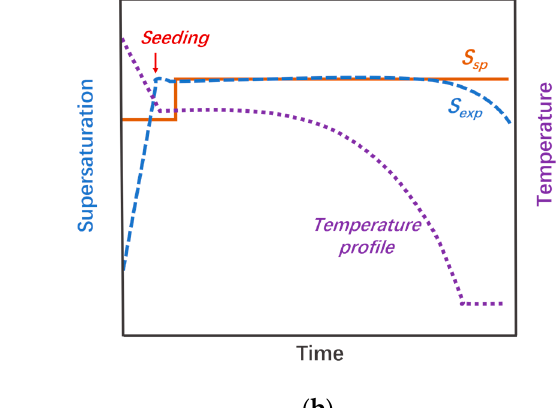
Figure 2. Generic block diagram of concentration feedback control approach.